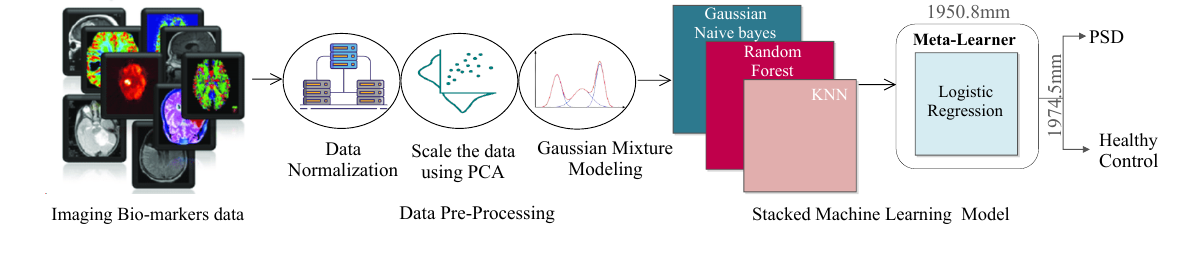
Figure 2. The proposed approach.